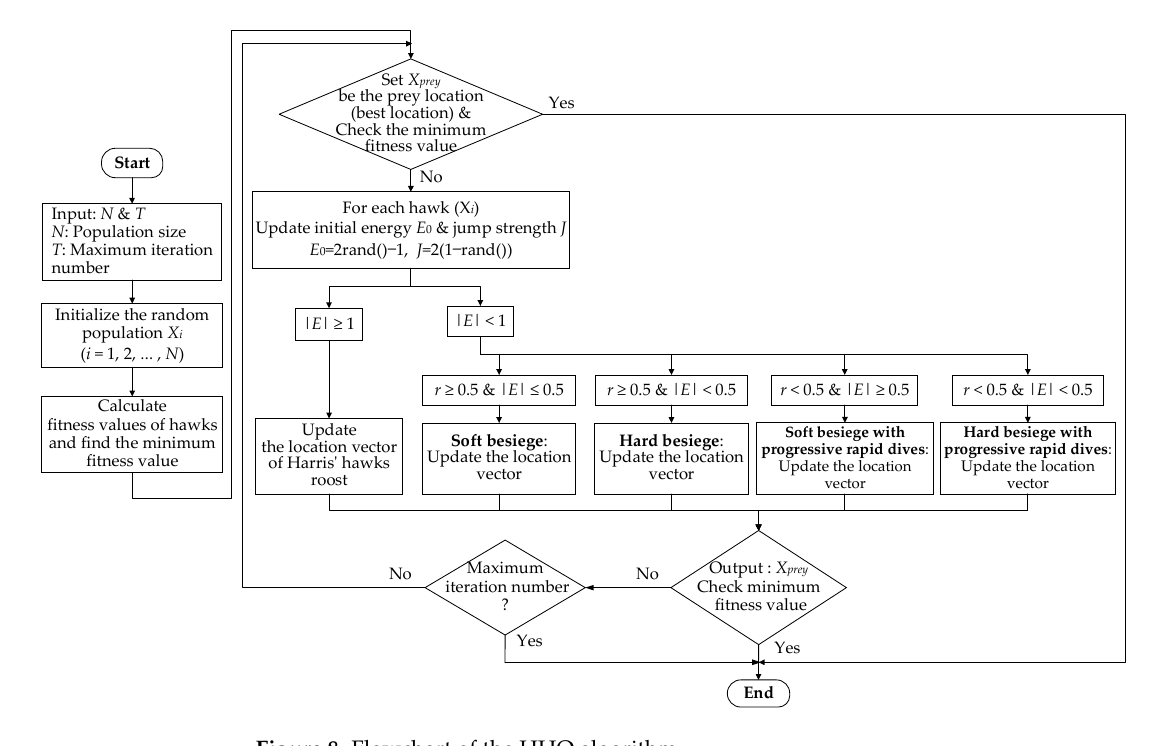
Figure 8. Flowchart of the HHO algorithm.